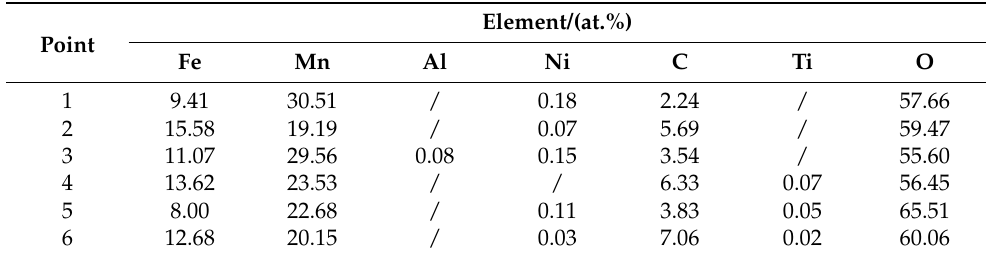
Table 3. EDS analysis of the surface layer of Fe-25Mn-9Al-8Ni-1C-xTi alloy oxidized for 200 h.